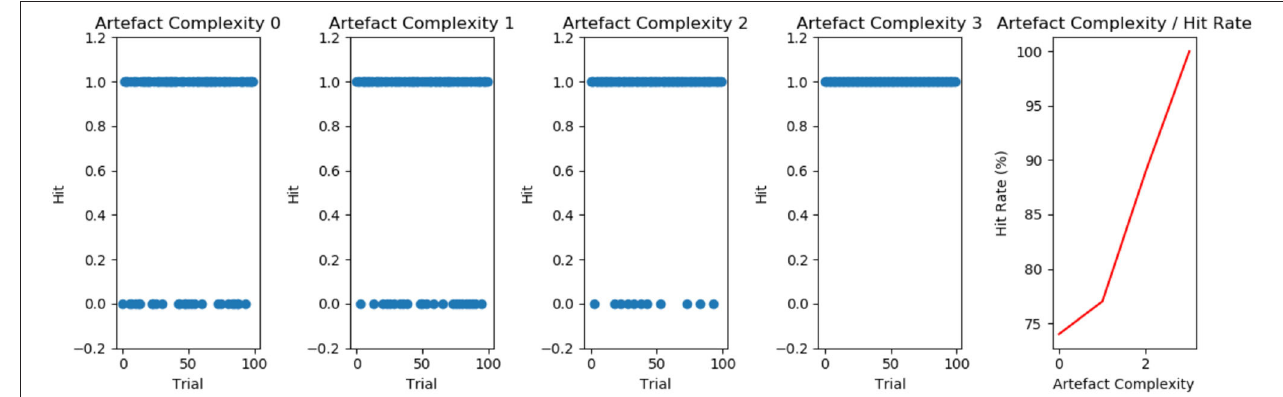
FIGURE 6 | From left to right: Hits (1.0) vs. non-hits (0.0) over 100 trials for agent’s exposed to different levels of artefact complexity. We find that the accuracy of agent’s guesses (percentage of hit-rate) correlates with the level of artefact complexity.